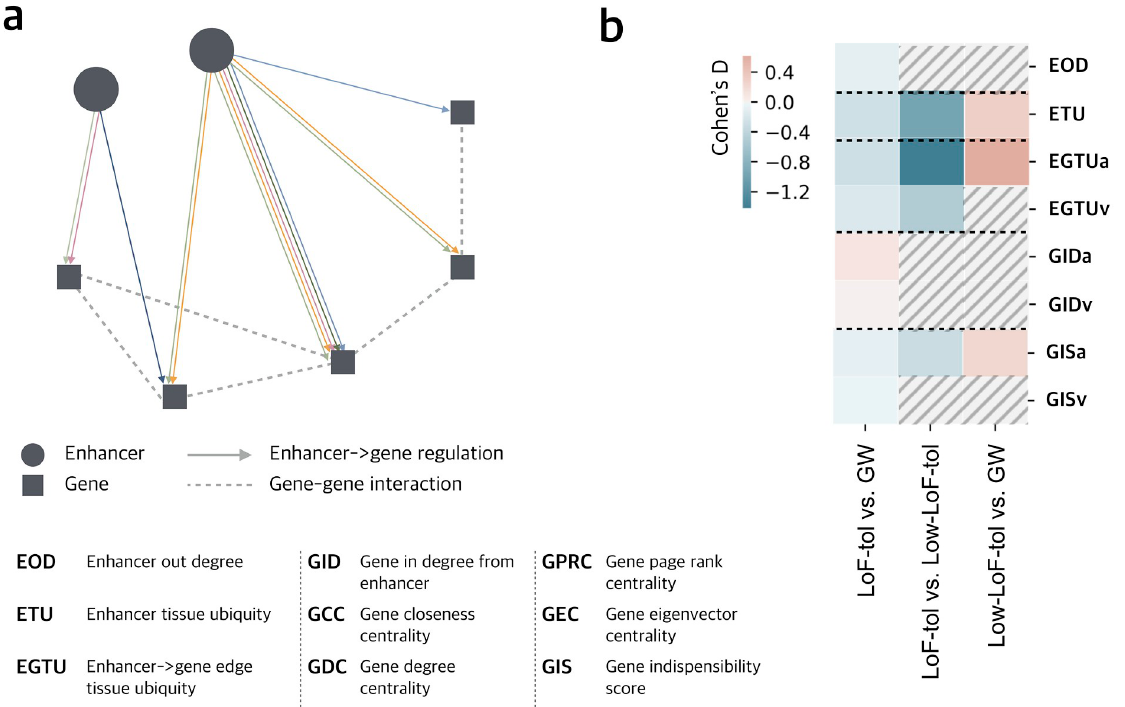
Fig 1. MegaNet features. a) Schema of the MegaNet, circle and square represent nodes for enhancers and genes, respectively, and colored directed arrows are enhancer- > gene regulation edges. Different colors represent the interactions active in different tissues. Dashed lines represent the gene-gene interactions. b) Comparison of network features between LoF-tolerant vs. genome-wide, LoF-tolerant vs. Low-LoF- tolerance and Low-LoF-tolerance vs. genome-wide enhancers. Significant comparison (Wilcoxon rank sum test, P-value < 0.05) are shown in color while non-significant ones are marked by dashed lines. Effective sizes of each comparison are shown by Cohen’s D in color scale. Positive Cohen’s D stands for higher average while negative values stand for lower average. LoF-tol, Low-LoF-tol and GW represent LoF-tolerant, low- LoF-tolerance and genome-wide respectively. ‘a’ and ‘v’ stand for the average and variance for the corresponding features in a), detailed feature description is in Table 1.